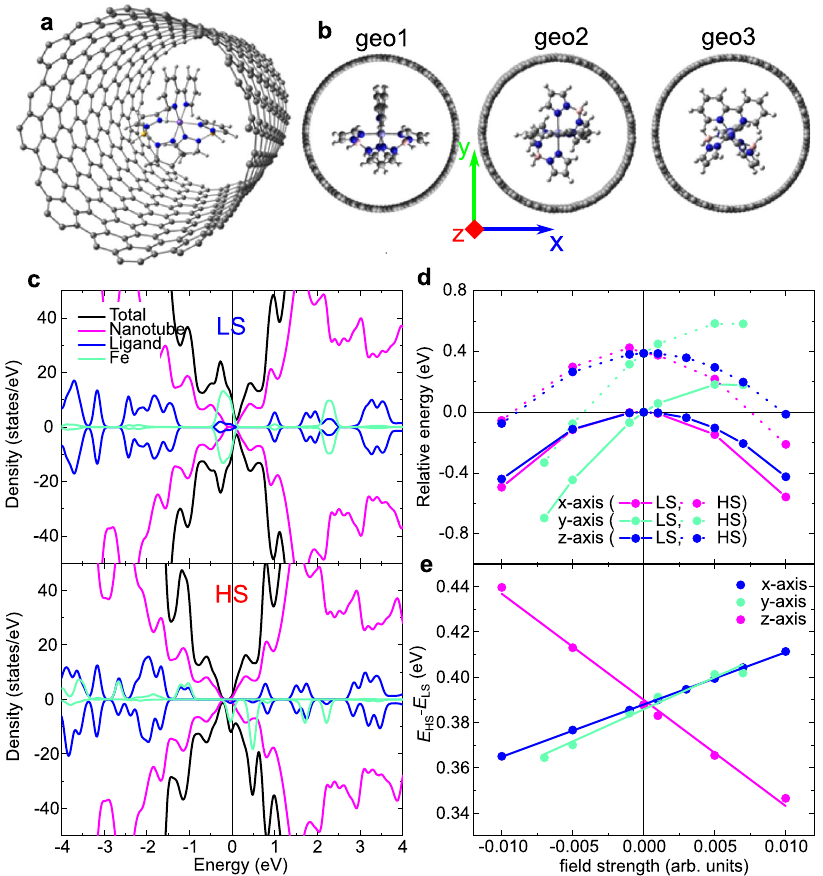
Fig. 4 DFT modeling of SCO@SWCNT. a Most stable geometry of SCO2 encapsulated on an SWCNT(16,8). b Three orientations of the SCO2 molecule with respect to the nanotube wall. c Density of states (black lines) and projected density of states on Fe (turquoise), complex ligands (blue) and carbon nanotube (magenta) of the SCO2@SWCNT hybrid for the LS (top) and HS (bottom) states of SCO2. d Relative energy (in eV) of the LS (solid lines) and HS (dotted lines) of the SCO2 complex in the presence of an external electric fi eld orientated along the x , y , or z axis. e Impact of the applied electric fi eld on the HS – LS energy difference ( E HS − E LS ) of the SCO2 complex.